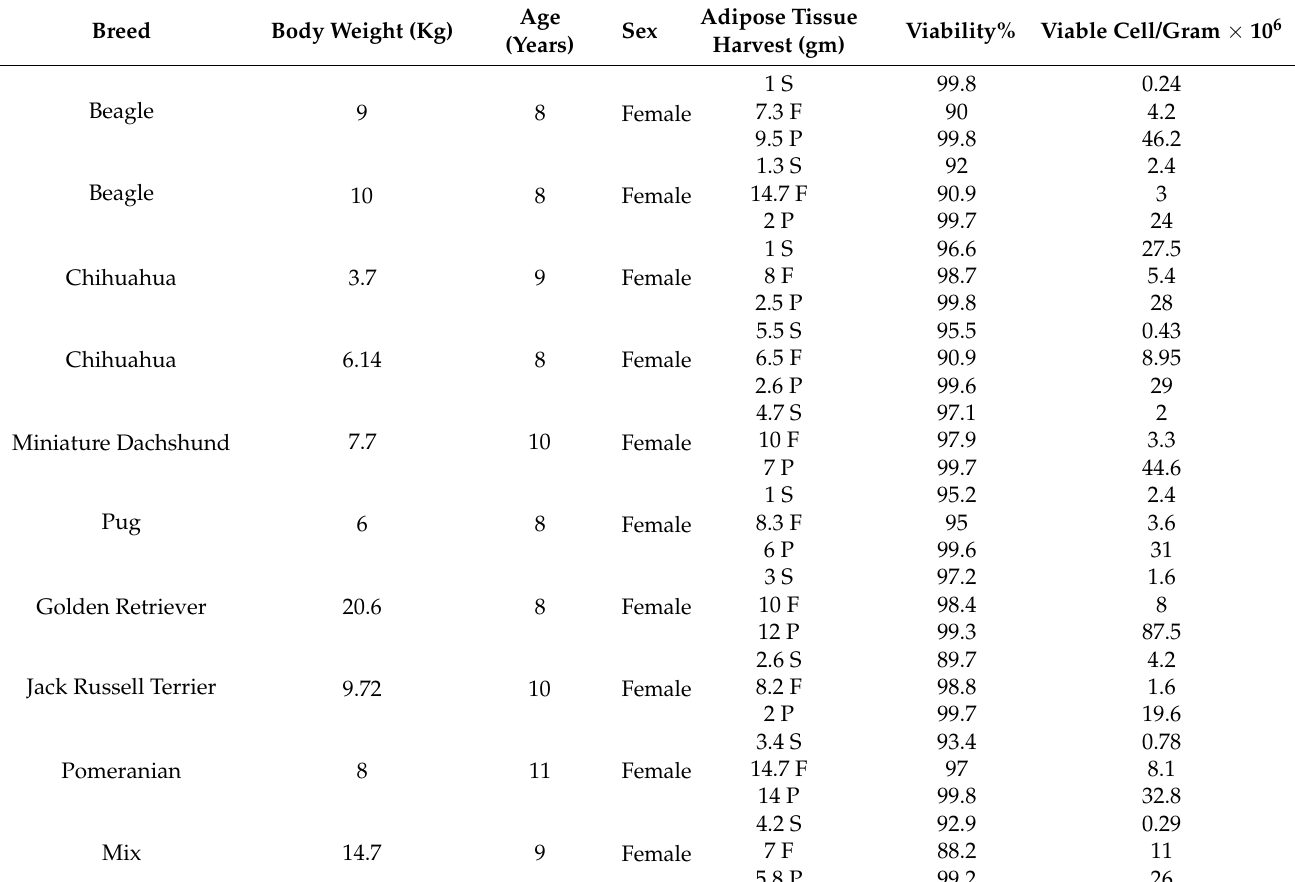
Table 3. Data of animals used in adipose tissue harvesting.